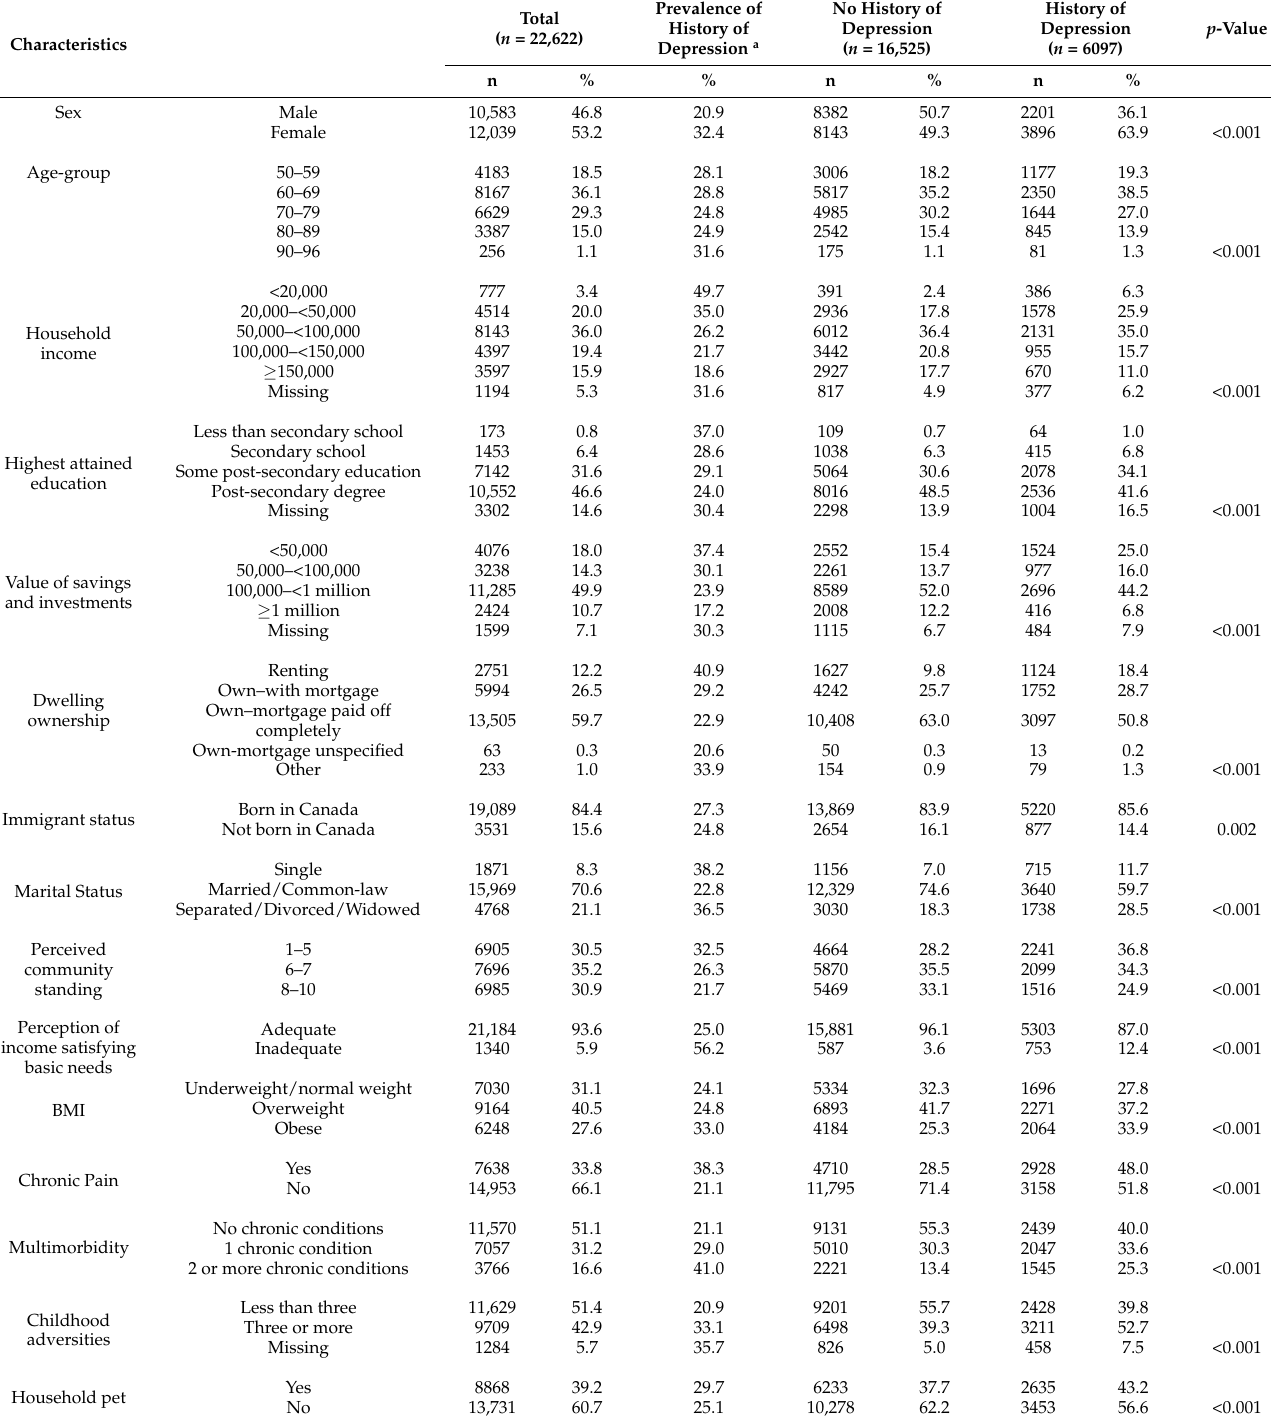
Table 1. History of depression across socio-demographic